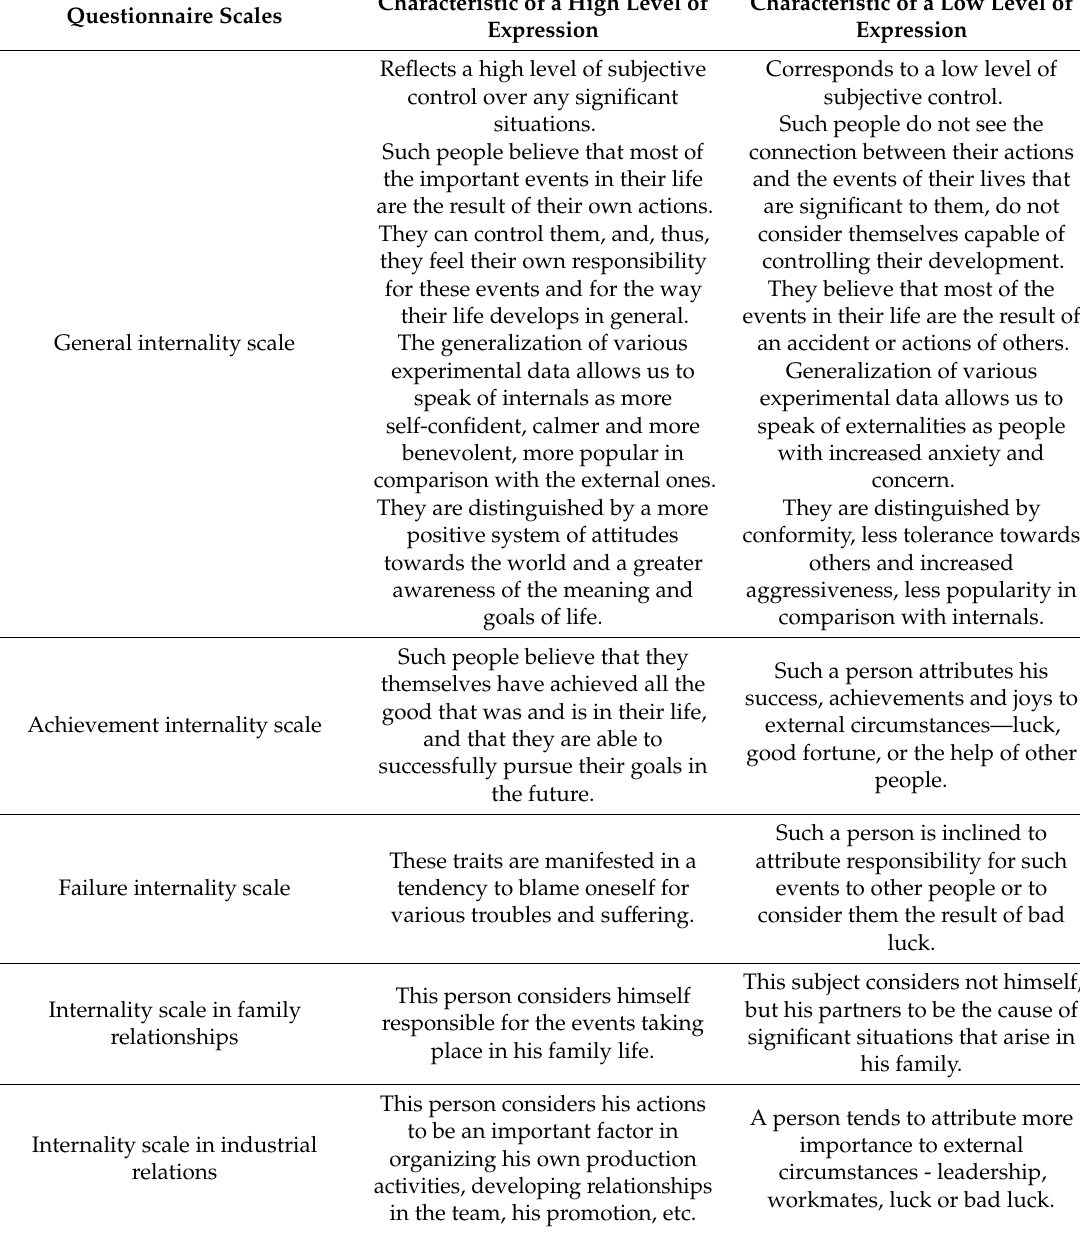
Table A2. Characteristics of the “subjective control level” questionnaire